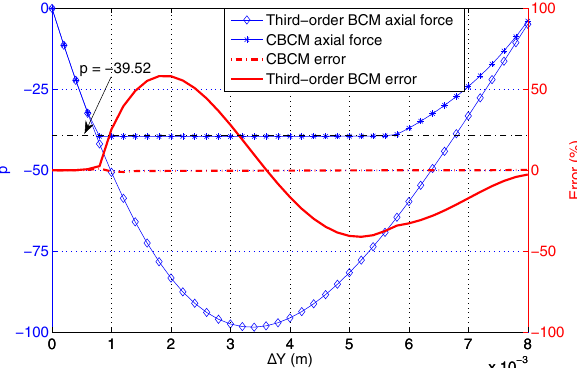
Figure 10. Comparision of normalized axial force and error of Ex- ample I.